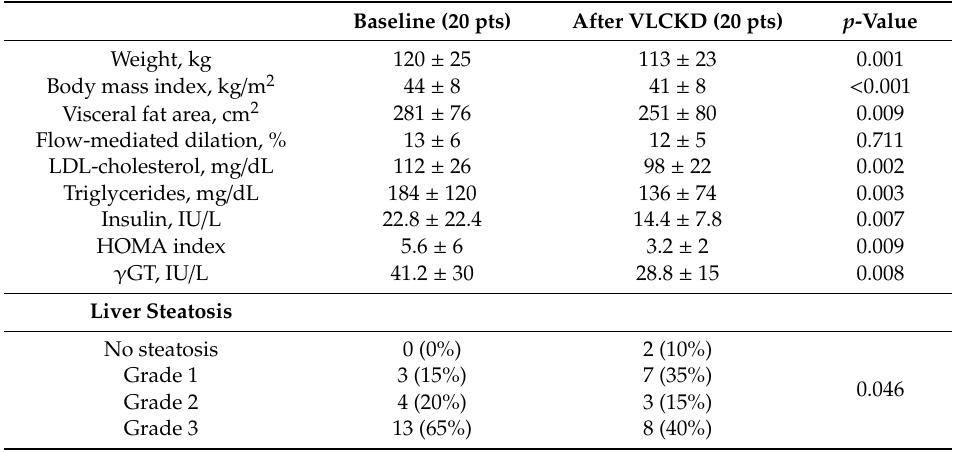
Table 3. Characteristics of subjects whose levels of lysosomal acid lipase activity were measured before and after VLCKD. Continuous values are expressed as mean ± standard deviation; distributions are expressed as numbers